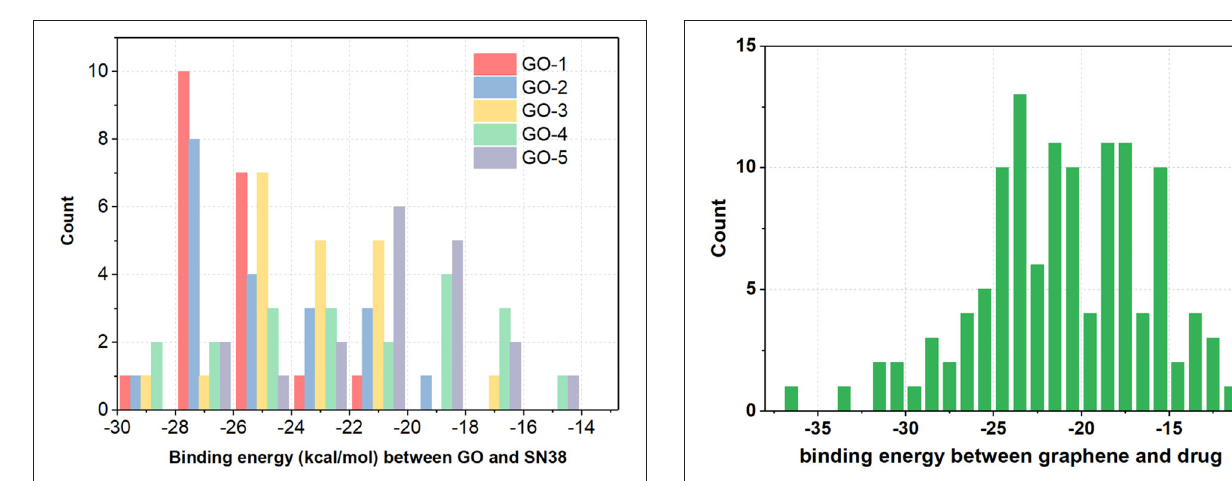
FIGURE 8 | The histogram of average binding energies (kcal/mol) between GO models and SN38. For each GO-X (X = 1, 2, 3, 4, and 5), all the GO-X models have the same functionalization rate with different functionalization sites.